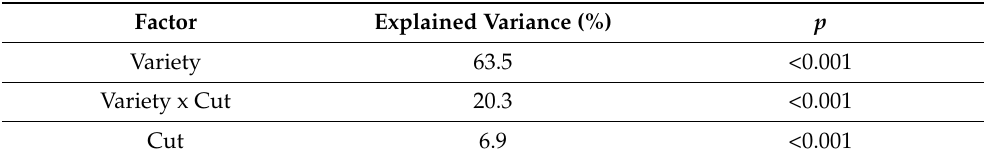
Figure 6. SCA for the effect of the interaction “year x variety”. ( a ) SC1 vs. SC2 Score plot. Empty symbols represent the projected residuals; ( b ) SC1 and ( c ) SC2 loadings plot. In ( a ), the different colors refer to the different varieties (blue—Italiano Classico; red—VAR 9; green—VAR 14), whereas different symbols refer to different harvesting years (circles—2019; triangles—2020; diamonds—2021). In loading plots, red lines indicate statistically significant regions, whereas blue lines indicate regions associated with loadings statistically indistinguishable from zero. Table 5. Explained variance and p -values for main factors and their second order interactions related to the ASCA